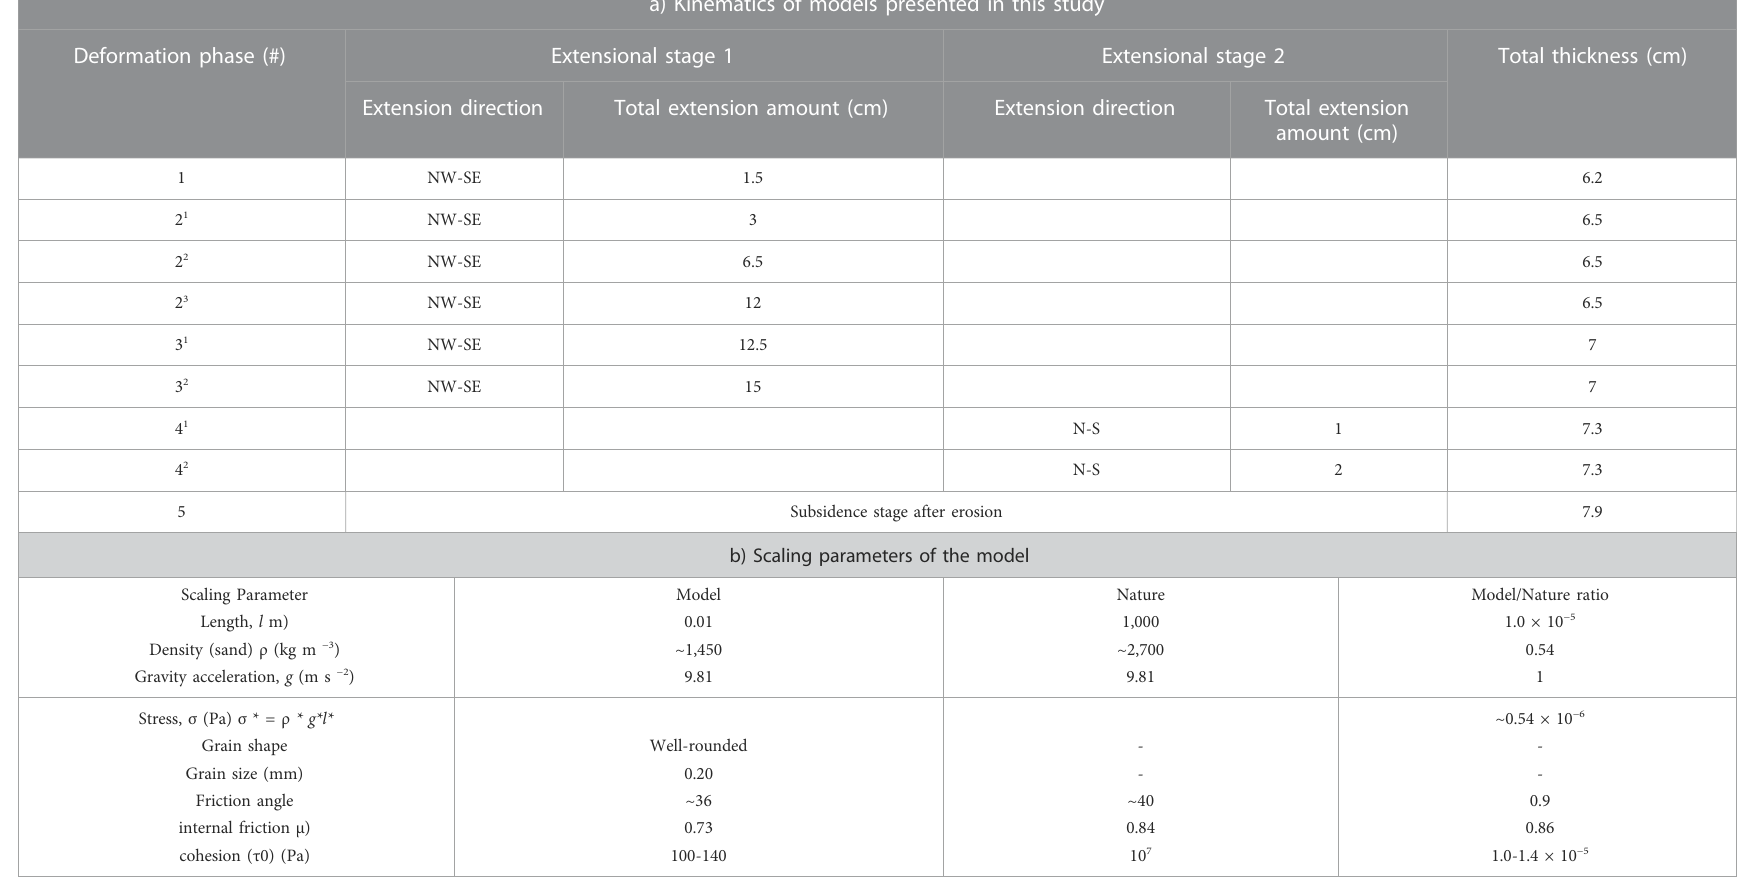
TABLE 1 Kinematics and scaling parameters of models presented in this